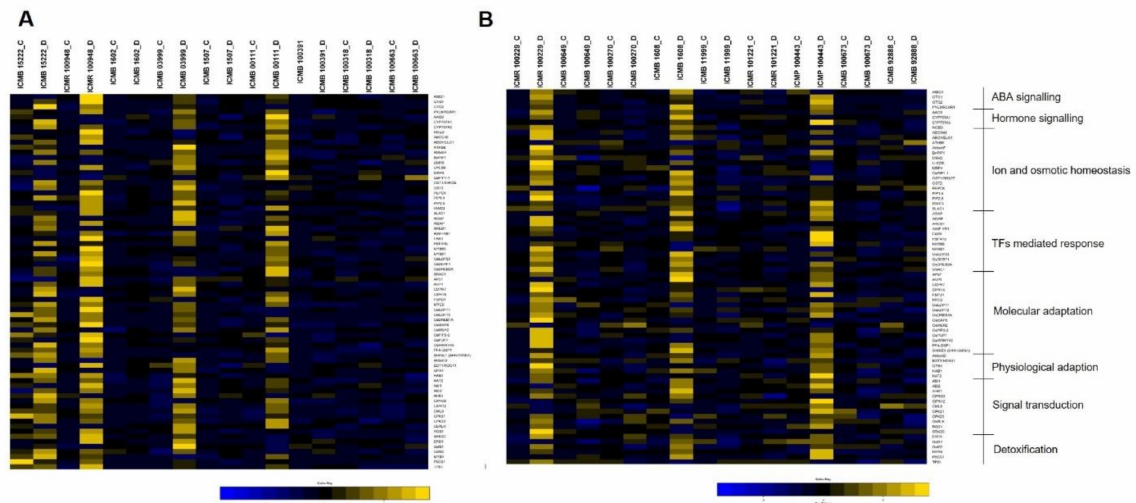
Figure 6. The heat map of 74 drought genes expressed in the ( A ) very-early and ( B ) early maturity group. The genotypes under drought (with suffix D) are compared with their respective control (with suffix